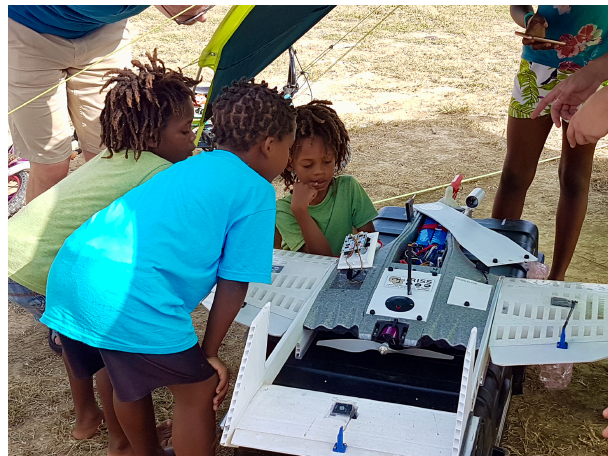
Figure 22. Local children helping to evaluate air worthiness of CU- RAAVEN UAS prior to launch from Morgan Lewis Beach (photo by Sandrine